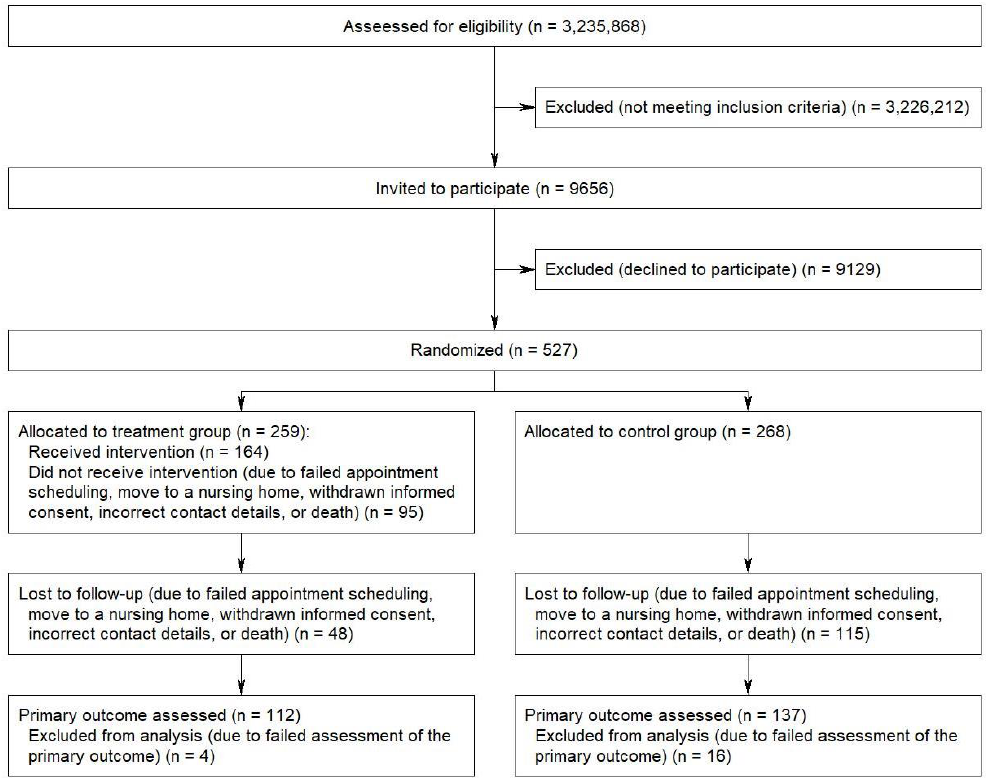
Figure 1. Flow diagram.